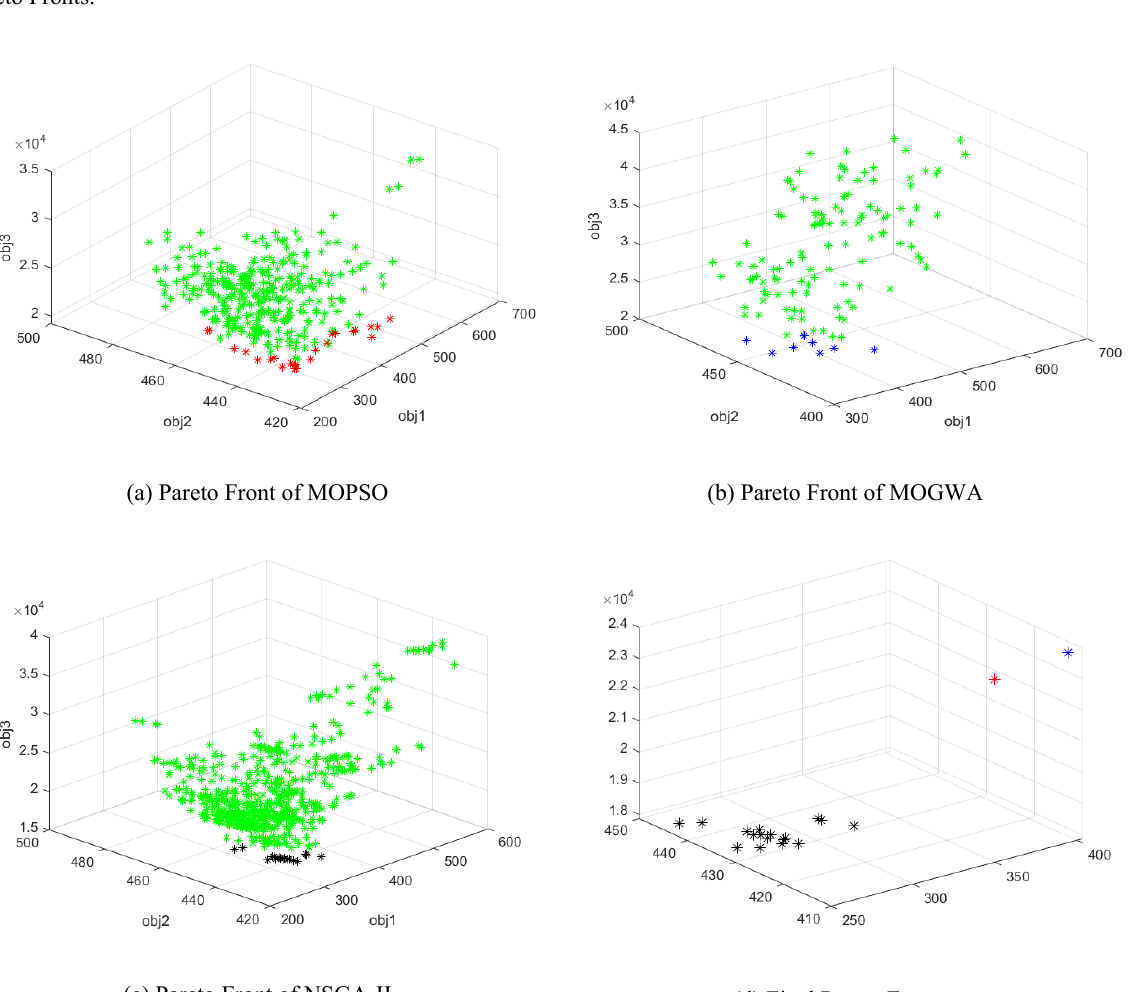
Fig. 6. Pareto Front in the second